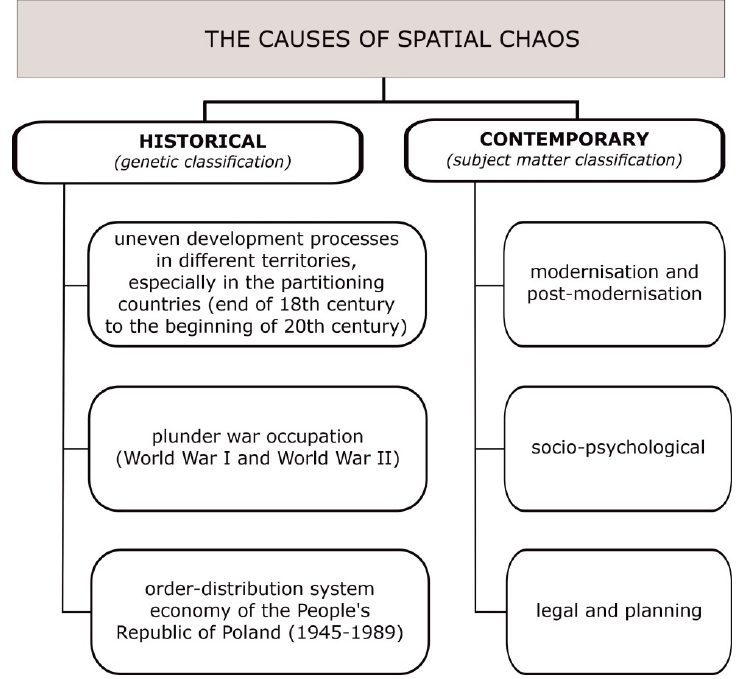
Figure 1. Classification of the causes of spatial chaos. Source: own study.